Question: Provide a one-line summary of what is displayed.
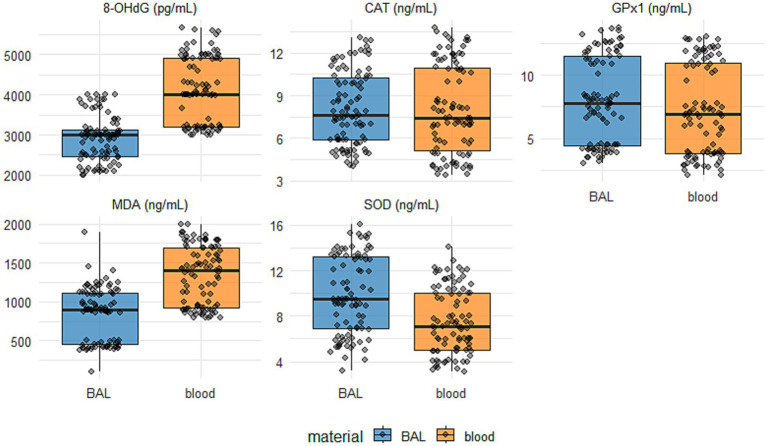
Answer: The concentrations of oxidative stress markers hydroxydeoxyguanosine (8-OHdG,) malondialdehyde (MDA) and antioxidants enzymes: superoxide dismutases (SOD), catalase (CAT), and glutathione peroxidase 1 (GPx1), in the BALF and serum of patients with severe brain injury. The parallel decline in SOD, CAT, and GPx over time, accompanied by a progressive rise in MDA and 8-OHdG.